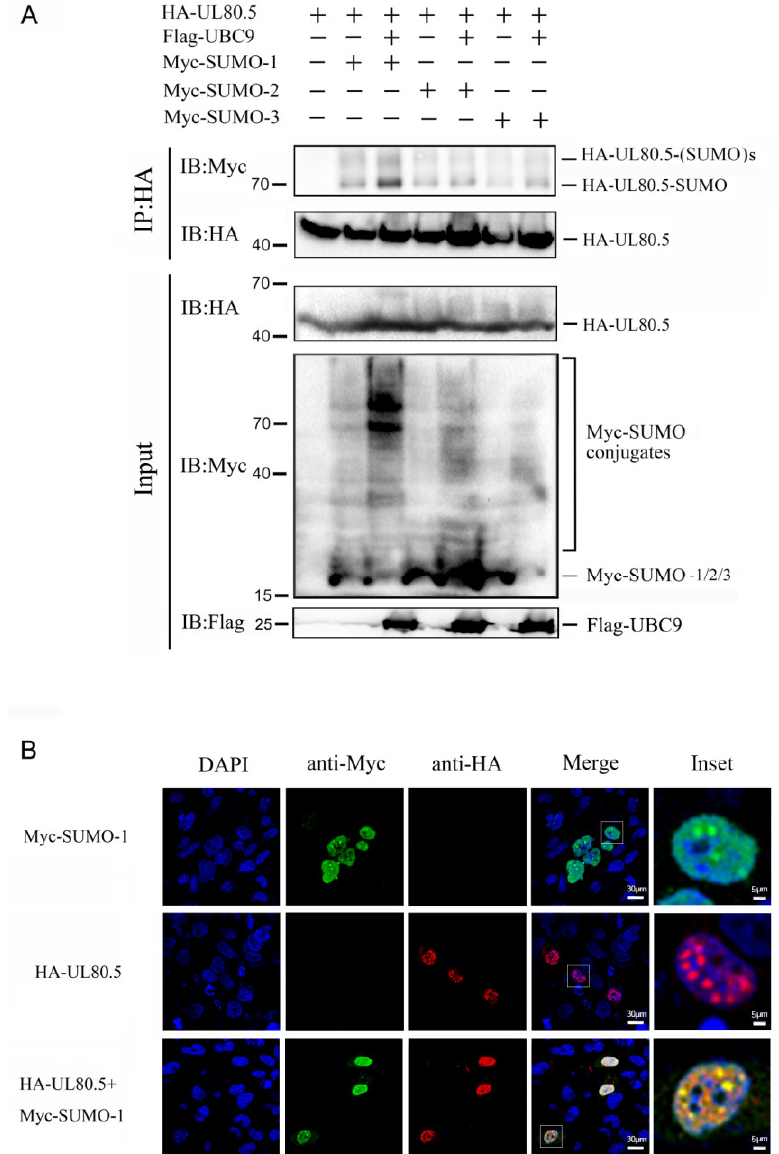
Figure 2. UL80.5 is mainly SUMOylated by SUMO1. ( A ) HEK293T cells were transfected with HA-UL80.5 and Myc-SUMO1/SUMO2 /SUMO3 with or without Flag-UBC9. Cell lysates were subjected to Co-IP with HA antibody followed by immunoblot analysis. Data are representative of three independent experiments. ( B ) U251 cells were transfected with HA-UL80.5 alone, Myc-SUMO1 alone, or HA-UL80.5 with Myc-SUMO1. Subcellular localizations of HA-UL80.5 (red), Myc-SUMO1 (green), and the nucleus marker DAPI (blue) were examined by confocal microscopy. Scale bars for DAPI, anti-Myc, anti-HA, and Merge are 30 µ m, and the scale bar for the inset is 5 µ m. Data are representative of three independent